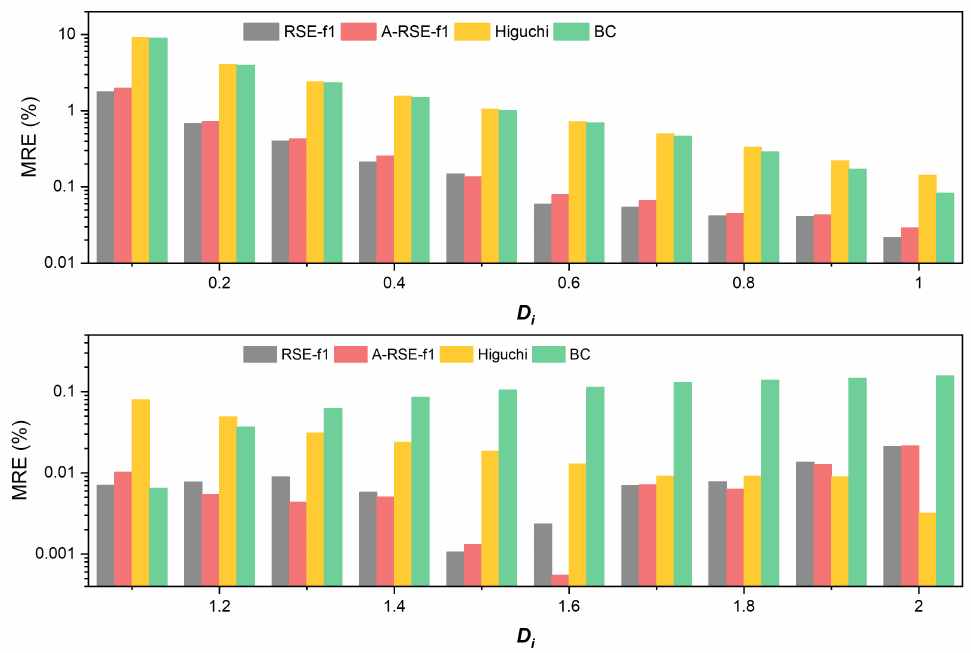
Figure 6. The logarithmic coordinate plot of the mean relative error (MRE) of RSE-f1, A-RSE-f1, Higuchi, and BC algorithms under different D i